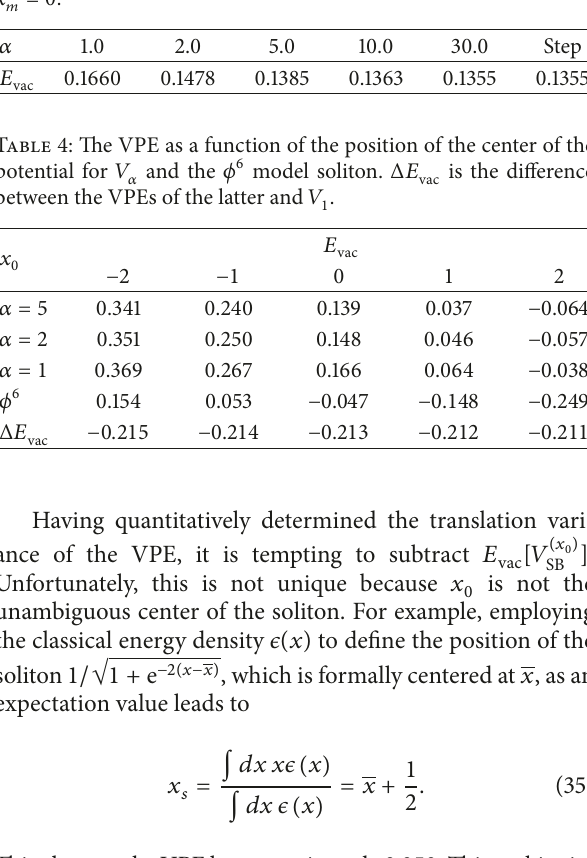
𝐴 = 0.2 , 𝜎 = 4.0 𝑎 Parity sep. (equation (15))